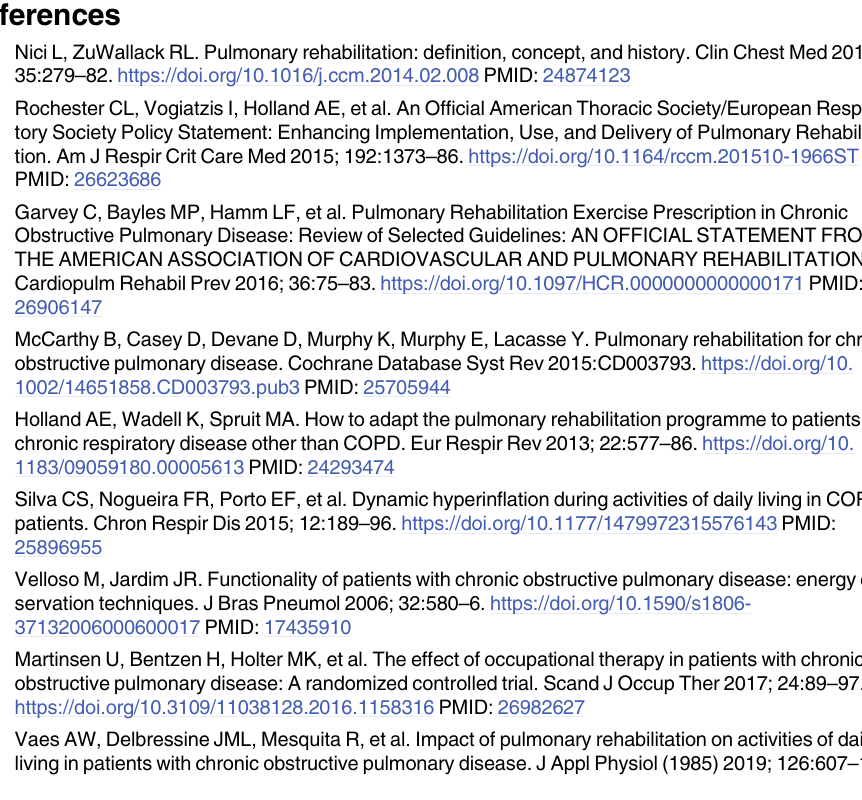
S1 Table. Comparison of patients who completed the pulmonary rehabilitation versus drop-out. S2 Table. Comparison of the change from baseline in patient outcomes between energy conservation vs. traditional pulmonary rehabilitation by COPD